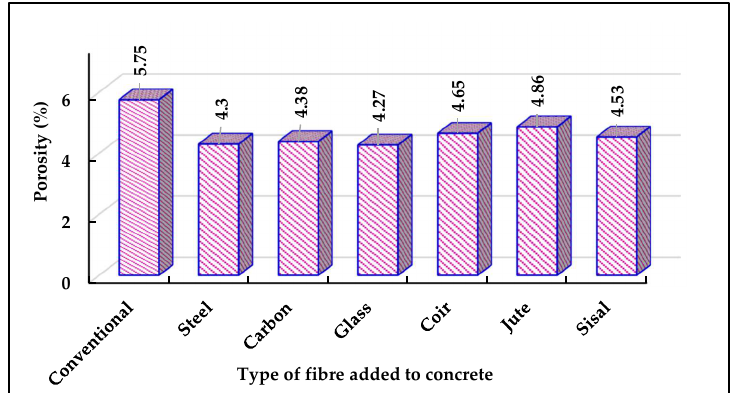
Figure 9. Graphical illustration of water absorption of FRC.